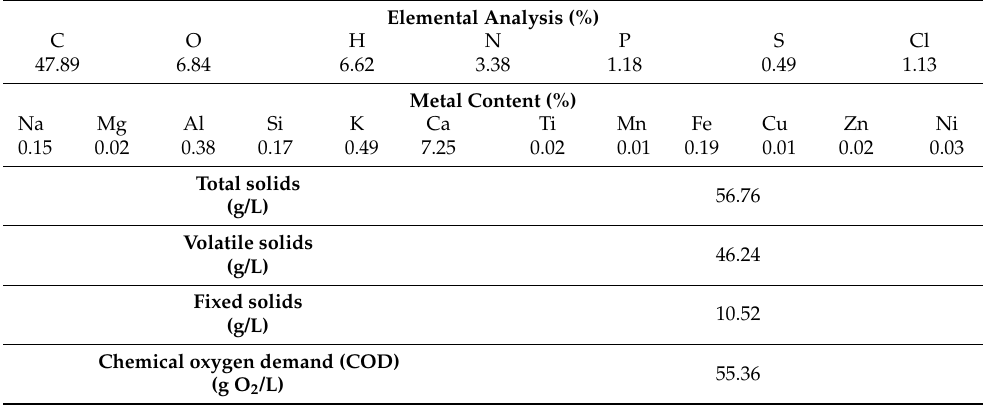
Table 1. Characterization results of the sludge.